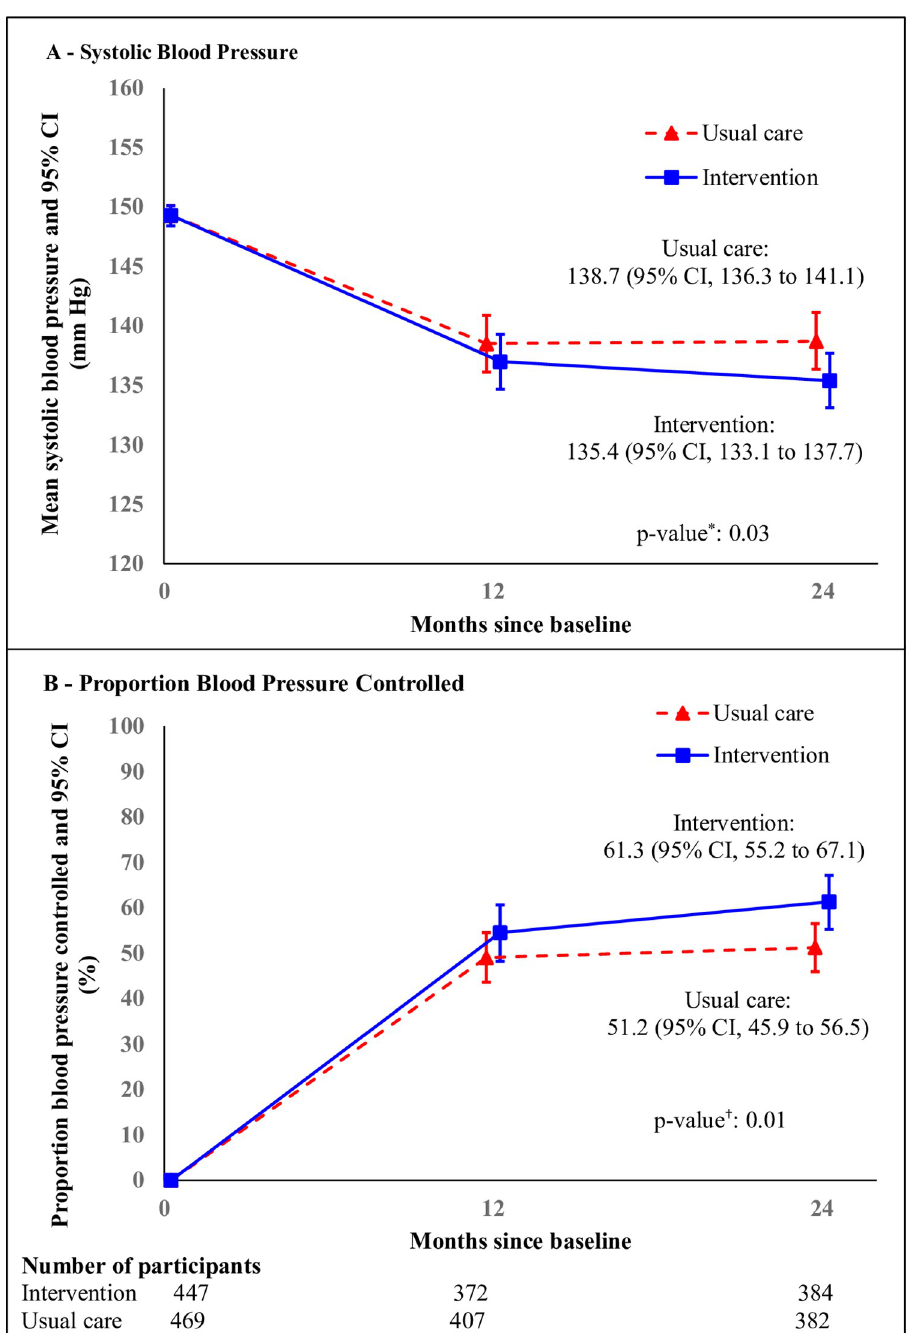
Fig 2. AU : AbbreviationlisthavebeencompiledforthoseusedinFigs 2 and 3 andTables 1 (cid:0) 3 : Pleaseverifythatallentriesarecorrect : Mean SBP and proportion BP controlled by treatment group over time. Panel A: Mean SBP was estimated with a generalized linear MMRM for SBP, with cluster random effects for clinic, and random effects for participants. The I bars indicate 95% CIs. � The p -value for the difference in the mean SBP between 2 treatment groups at 24 months was 0.03. Panel B: Proportions BP controlled were estimated at 12 months and 24 months using a generalized linear mixed-effects model for BP control (SBP < 140 mmHg and DBP < 90 mmHg) as repeated measures, with fixed effect of baseline SBP, cluster random effects for clinic, and random effects for participants. The I bars indicate 95% CIs. †The p -value for the difference in the proportion BP controlled between 2 treatment groups at 24 months was 0.01. BP, blood pressure; CI, confidence interval; DBP, diastolic BP; MMRM, mixed model repeated measure; SBP, systolic BP.